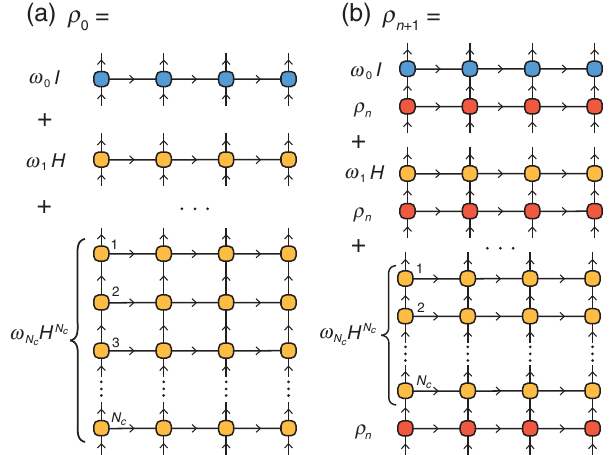
FIG. 3. (a) SETTN initialization of ρ 0 (with β ¼ τ 0 ) using Maclaurin expansion with coefficients ω k ≡ ð − τ 0 Þ k =k ! [see Eq. (7a)]. (b) Pointwise SETTN algorithm exploiting the loga- rithmic β scale, here with coefficients ω k ≡ ð τ n − τ n [see Eq.